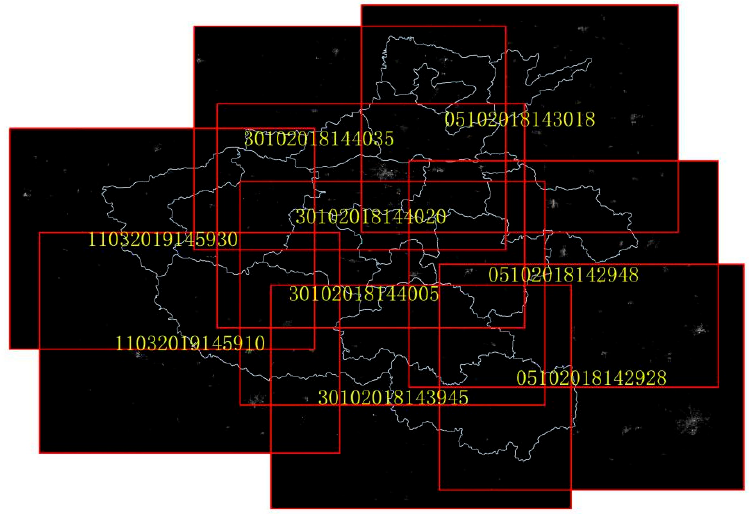
Table 1. List of Luojia I Night-Time Light (NTL) images data.